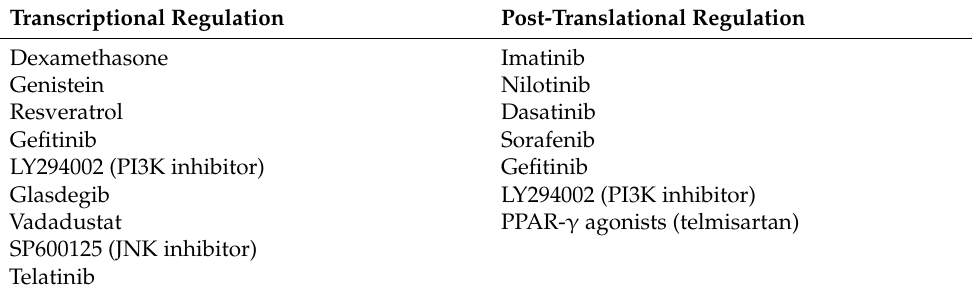
Table 4. ABCG2 expression modulators according to regulation